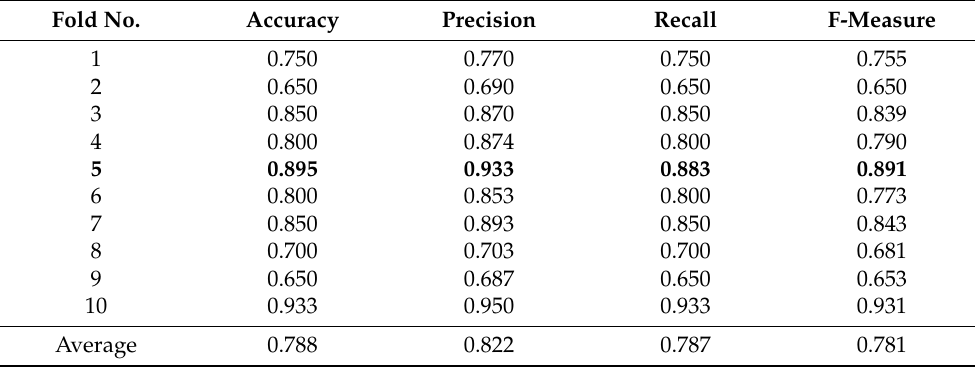
Table 7. Accuracy, precision, recall, and F-measure of proposal method (male-only). Fold